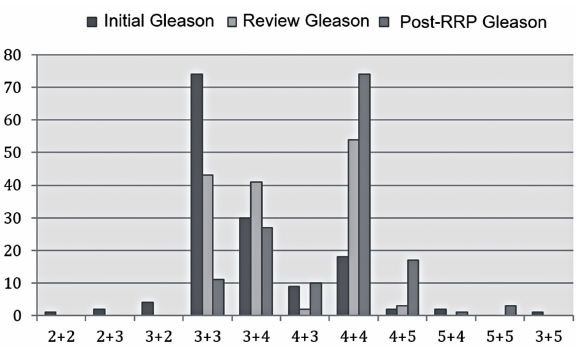
Figure 2 - Initial, post - review and after RRP GS only of patients submitted to surgery.